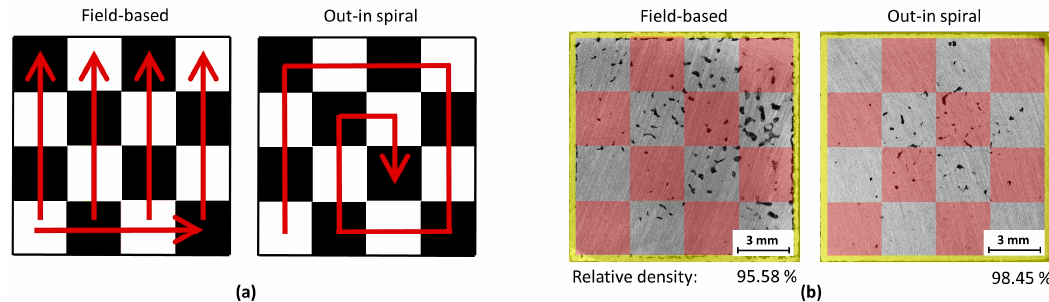
Figure 8. ( a ) Scanning order of individual chessboard fields for different settings of the chessboard strategy; ( b ) Comparison of sample defects for field-based and out-in spiral setting of the chessboard strategy; to visualize the real in size and distribution of black and white fields over the ground sample, the white fields are shown with a transparent red color.